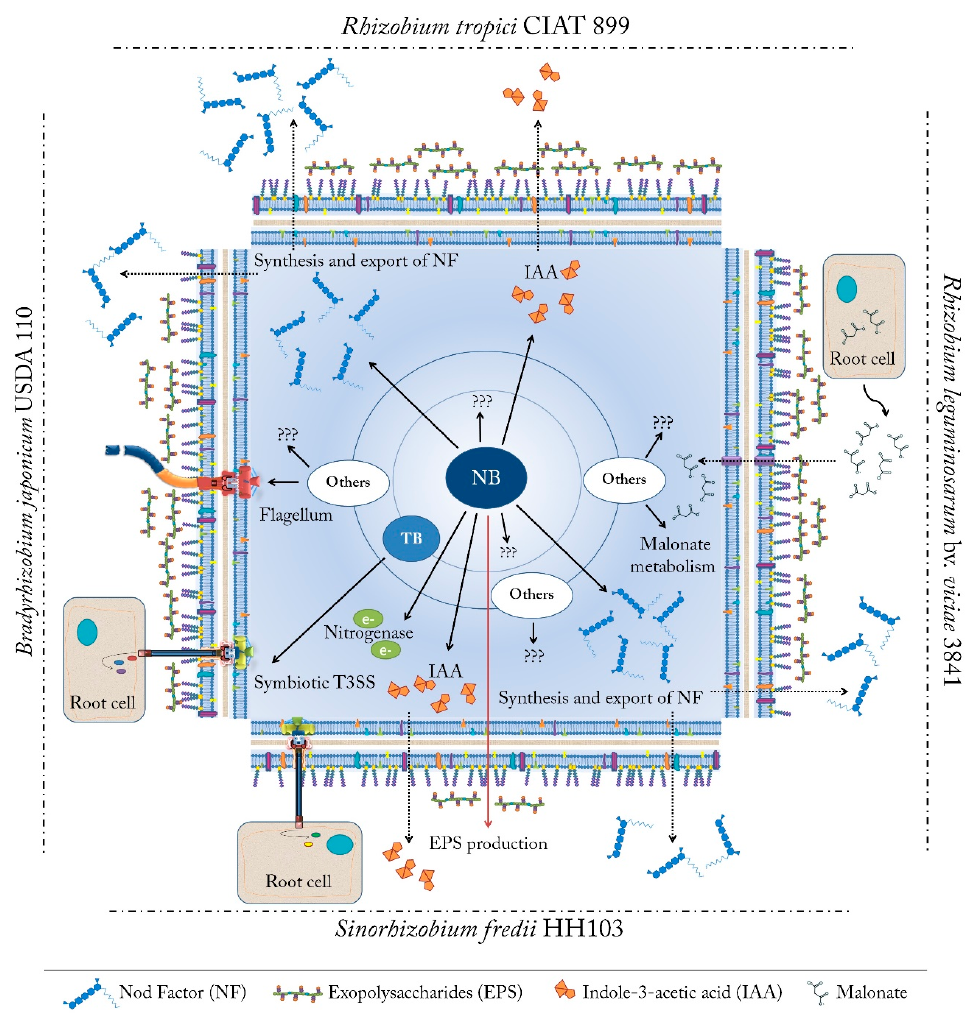
Figure 6. Molecular responses triggered by inducing flavonoids according to transcriptomic reports in several rhizobial strains. NB: nod boxes, TB: tts boxes. Black arrows: activation. Red Arrows: repression. Dotted arrows indicate transport across the membrane and cell wall.